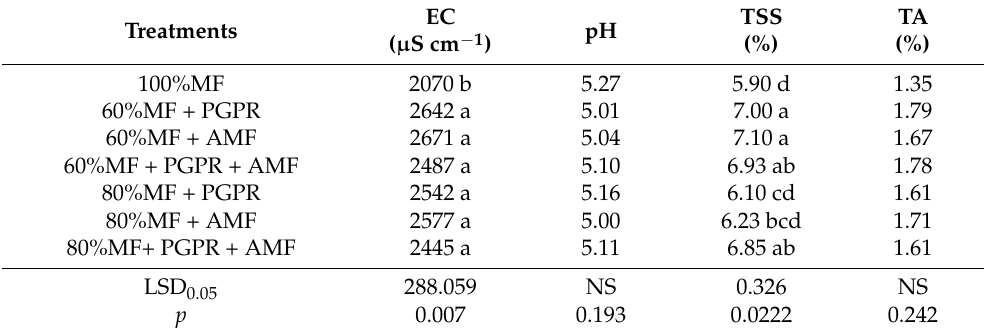
Table 5. Effects of the treatments on chemical properties of capia pepper